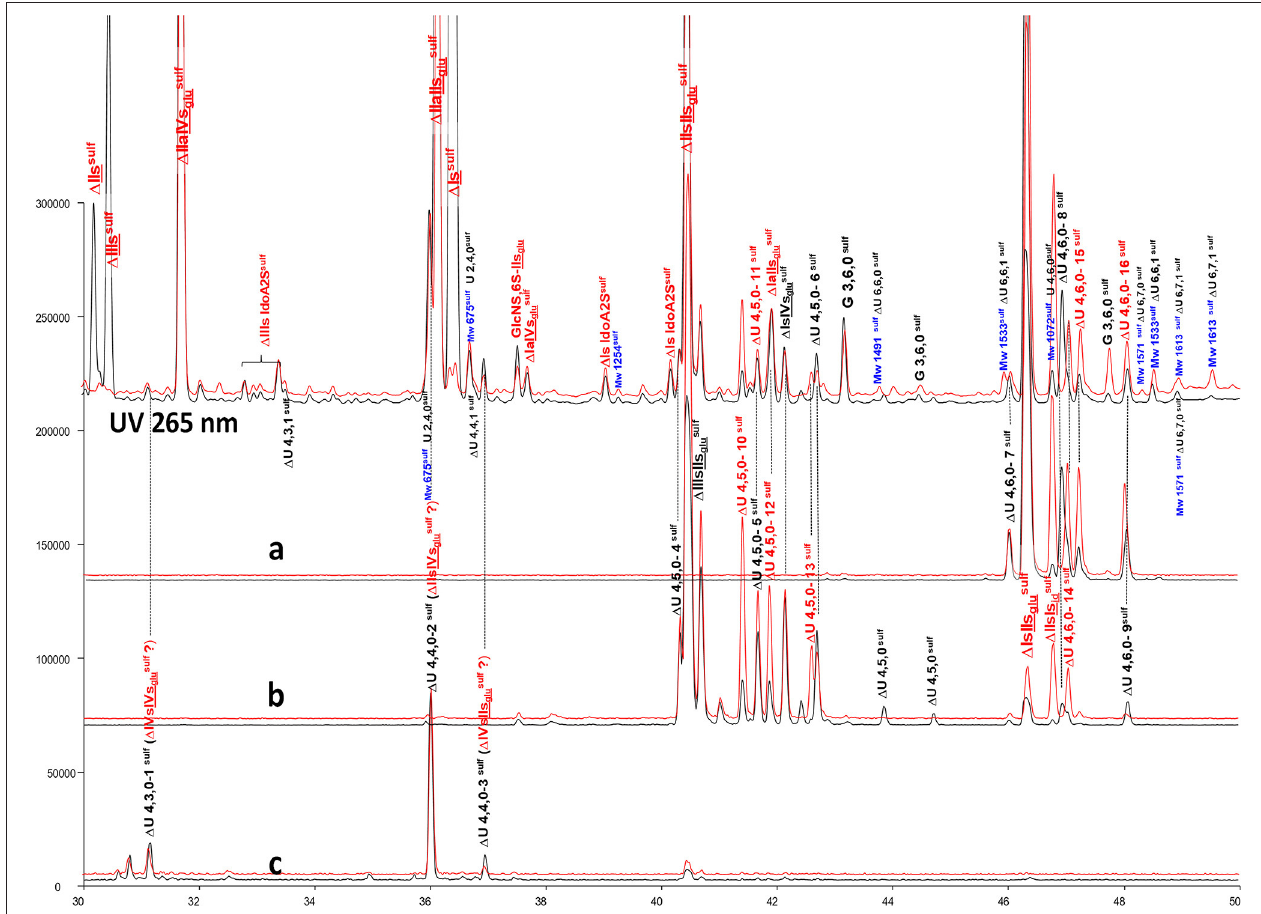
FIGURE 8 | Comparison by ion-pair liquid chromatography/mass spectrometry of heparinase I + II + III ( — ) and heparinase II ( — ) digests of bovine mucosal heparin high-affinity (HA5) fraction after sulfanilic reductive amination. (a) Reconstructed ion pair chromatograms (RIC) 1 U(4,6,0) sulf : m/z 712.2; (b) RIC 1 U(4,5,0) sulf : m/z 614.5 + 672.1; (c) RIC 1 U(4,4,0) sulf + 1 U(4,3,0) sulf : m/z